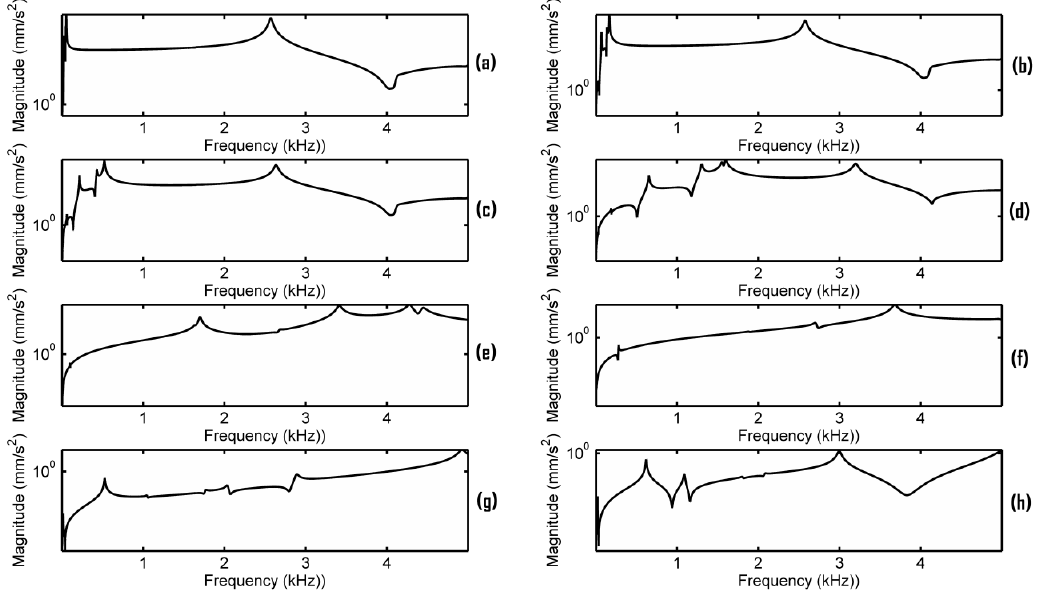
Figure 5. Frequency responses of the bridge in Figure 1a under different contact stiffness with the damping ratio 0.7% critical. EPS1 was set as ( a ) 0.001; ( b ) 0.01; ( c ) 0.1; ( d )